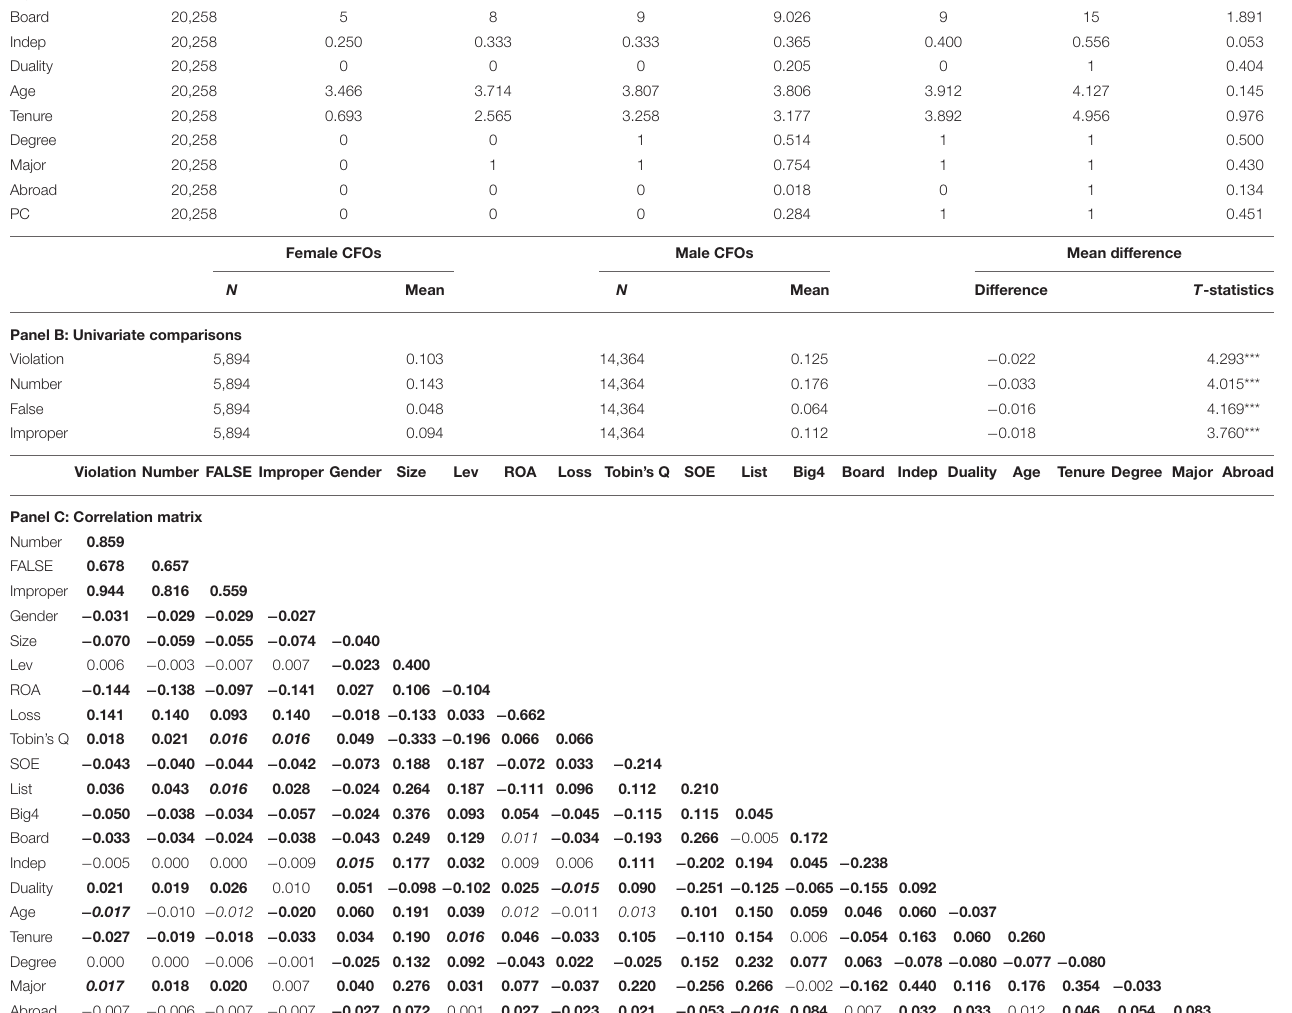
Panel A: Summary statistics Violation